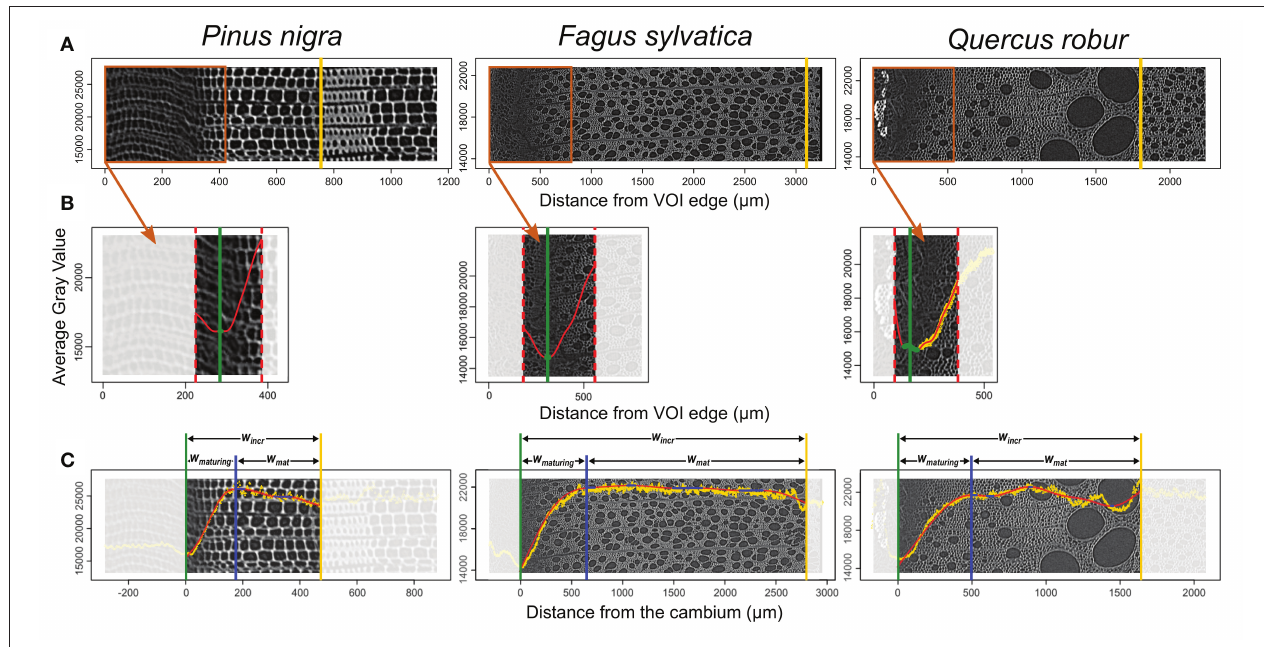
FIGURE 4 | Implementation of the gray-value profiling. (A) The average gray value of each tangential slice is plotted on the reference cross-section image. At this stage, the previous growth ring boundary is identified (yellow vertical line). (B) Within the subset containing the cambium, a GAM fit (red) and its derivative allow automatic identification of the cambium position (green vertical line). (C) Within the growth ring, a GAM fit (red) and its derivative allows the detection of a constant gray value (blue filled circles). The constant gray value closest to the cambium is set as the boundary between maturing and mature xylem (blue vertical line). This procedure allows to estimate maturing xylem width ( w maturing ), mature xylem width ( w mature ), and increment width ( w incr ). The gray scale is unitless. It varies from 0 to 65,535 for 16 bits images used